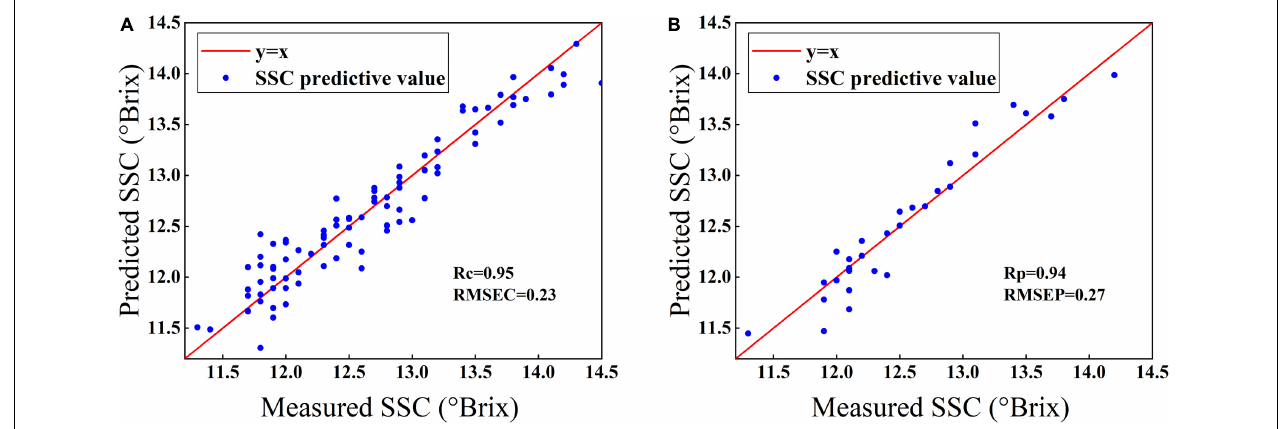
FIGURE 5 | Measured vs. predicted values for SSC prediction of Korla fragrant pears by BOSS-SPA-PLS models. (A) Samples in the calibration set and (B) samples in the prediction set.